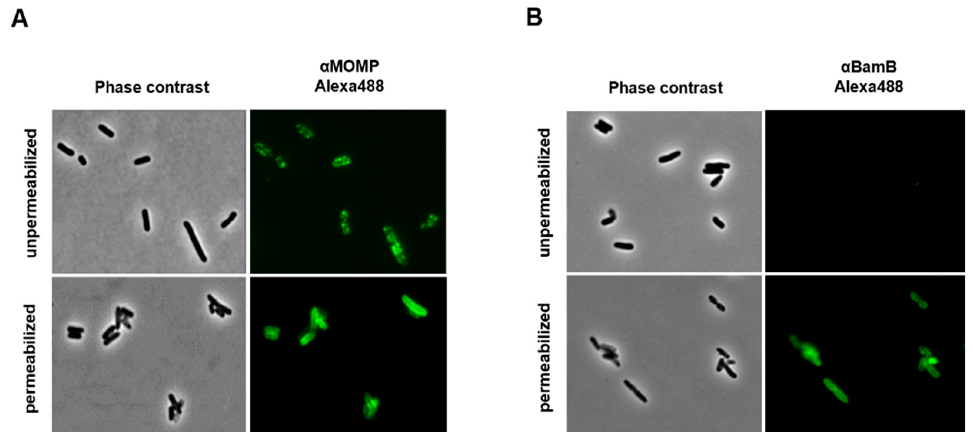
Figure 6. Ct -MOMP was exposed at the surface of E. coli . Cells co-expressing Ct -MOMP and Bam complex were fixed and subjected to indirect immunofluorescence microscopy using rabbit polyclonal antisera against Ct -MOMP ( A ) or BamB ( B ) and Alexa Fluor 488 labeling/conjugation of antiserum. The intact cells were permeabilized with Triton-X100 and lysozyme prior to antisera incubations when indicated. Corresponding phase-contrast microscopy fields were also shown. The scale bar was 10 μ m. Images were processed using ImageJ software (http://rsb.info.nih.gov/ij/).